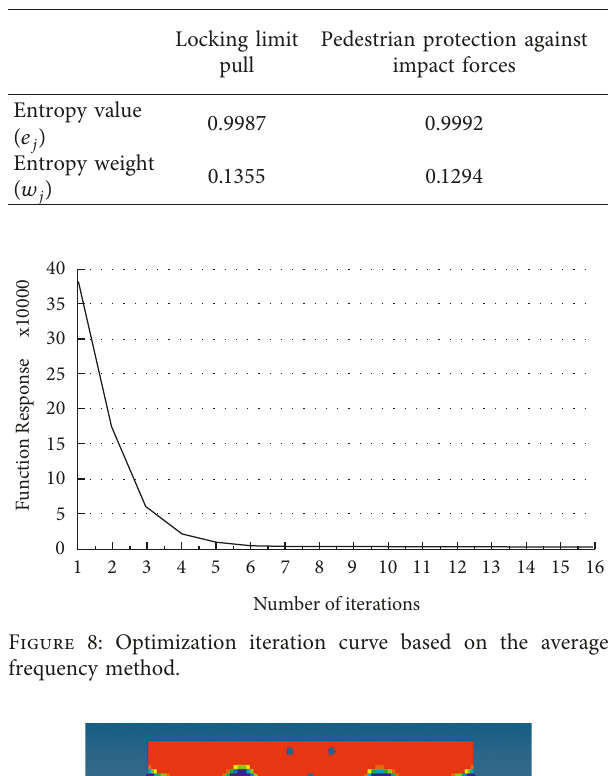
Table 4: Entropy weights for each subgoal.